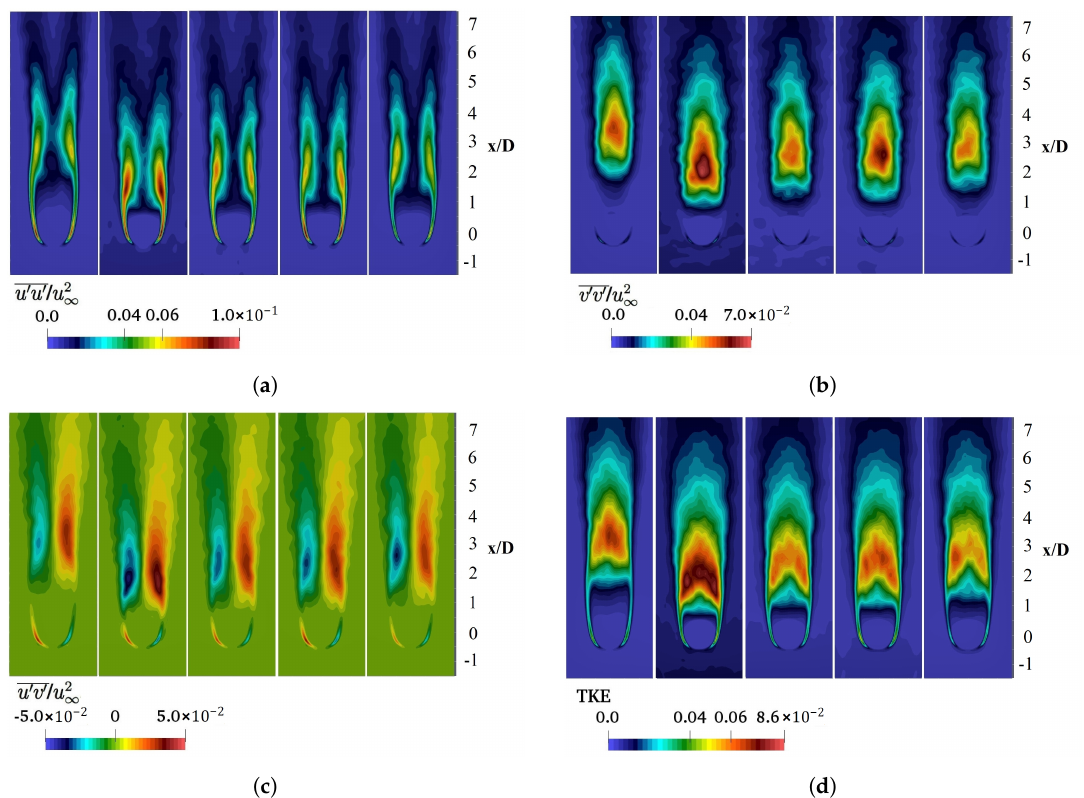
Figure 19. Comparison of the Reynolds stresses and turbulent kinetic energy of the 2 mm water drops falling in stagnant and turbulent surroundings: ( a ) u (cid:48) u (cid:48) / u 2 ∞ . ( b ) v (cid:48) v (cid:48) / u 2 ∞ . ( c ) u (cid:48) v (cid:48) / u 2 ∞ . ( d ) Turbulent kinetic energy. From left to right: cases D2T0, D2L050T10, D2L025T10, D2L050T05, D2L025T05.